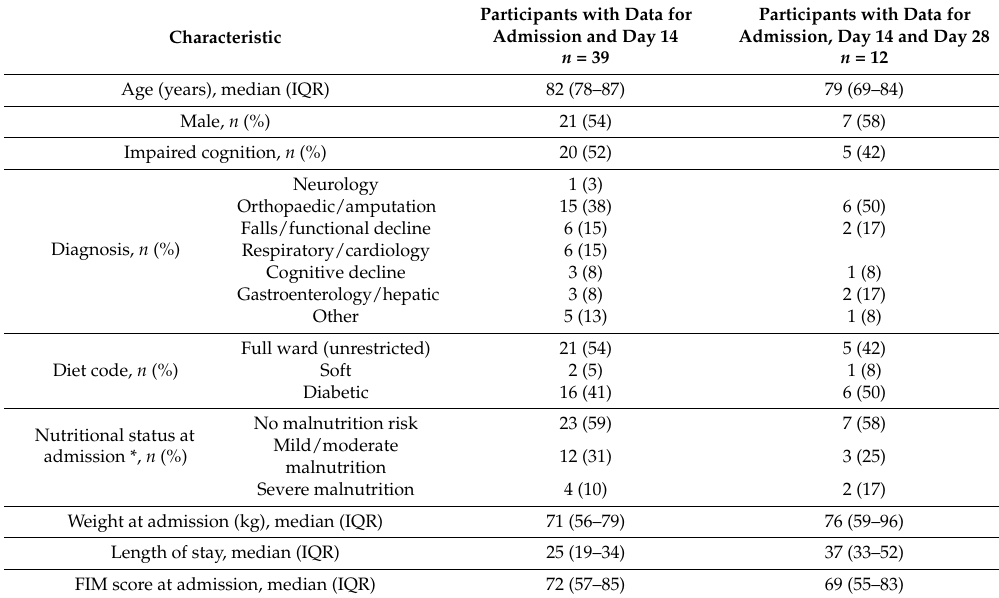
Table 1. Demographic characteristics of study participants included in analyses.